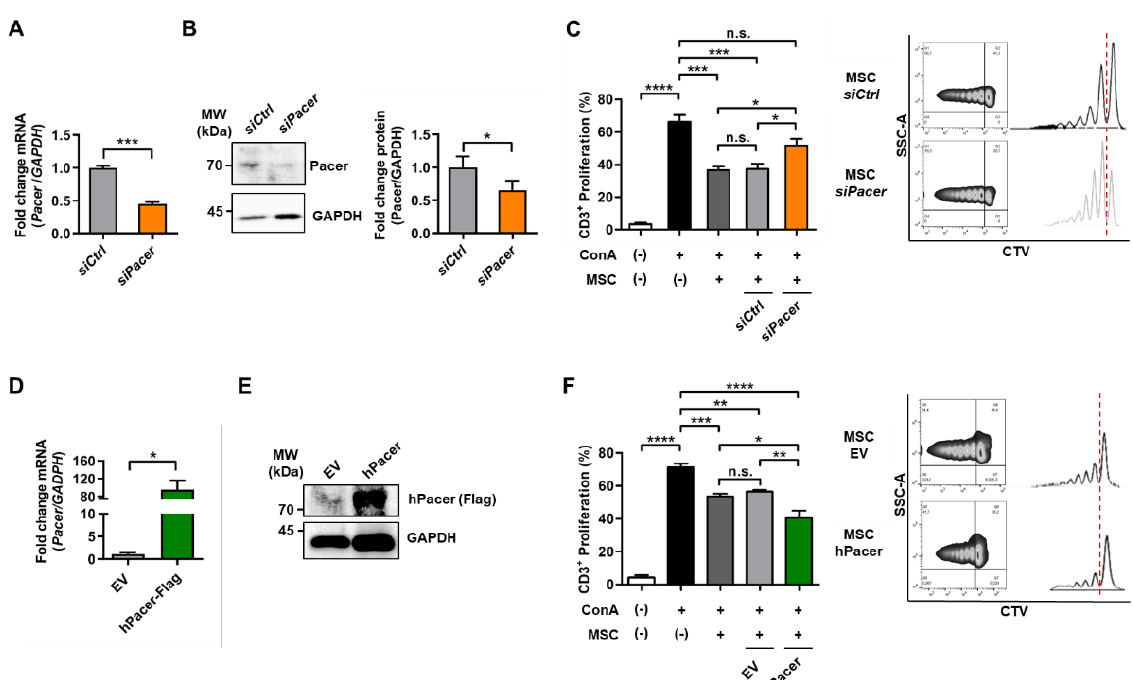
Figure 3. Increased levels of Pacer in MSC enhance their immunosuppressive capabilities upon T cells. ( A – C ) Depletion of endogenous Pacer levels in MSC using siRNA oligos. ( A ) mRNA levels of Pacer in MSC treated with si Pacer or si Ctrl oligos analyzed by quantitative PCR ( n = 4). GAPDH mRNA levels are used as a reference. ( B ) Western blot and quantitative analysis of Pacer levels in MSC transiently transfected with si Pacer or si Ctrl oligos ( n = 4). GADPH protein levels are used as a loading control. ( C ) Co-culture assay of CD3-positive (CD3+) splenocytes with MSC transiently transfected with si Pacer or si Ctrl oligos ( n = 7). Splenocyte proliferation was induced with 1 µ g/mL Concanavalin A (ConA). T-cell proliferation was evaluated using flow cytometry, gating SytoxGreen-negative staining (live CD3+ cells) and assessing cell trace violet (CTV) staining. ( D – F ) Augmented expression of Pacer in MSC transduced with lentiviral particles carrying human Flag-tagged Pacer (hPacer) or an empty control vector (EV). ( D ) mRNA levels of total Pacer in hPacer and EV MSC was determined by qPCR using primers recognizing mouse and human Pacer mRNA with comparable efficiency ( n = 4). GAPDH mRNA levels are used as a reference. ( E ) Western blot analysis of Flag-tagged human Pacer expression in MSC. GAPDH protein levels were used as a loading control. ( F ) Co-culture assay of CD3-positive (CD3+) splenocytes with hPacer or EV MSC ( n = 4). Splenocyte proliferation was induced with 1 µ g/mL Concanavalin A (ConA). T-cell proliferation was evaluated using flow cytometry, gating SytoxGreen-negative staining (live CD3+ cells) and assessing cell trace violet (CTV) staining. In ( A – D , F ), Mean ± SEM are shown. In ( A , B , D ), Student’s t -test was performed ( n = 4) and in ( C , F ), one-way ANOVA with Tukey post hoc test was performed for statistical analysis ( n = 7). Only significant p values are shown. p values: *, p ≤ 0.05; **, p ≤ 0.01; ***, p ≤ 0.001; ****, p ≤ 0.0001. 3.3. Increasing Pacer Levels in MSC Improves Their Therapeutic Effect in a Mouse Model of DSS-Induced Colitis Since increased Pacer levels enhanced the immunosuppressive capacity of MSC in vitro, we tested whether hPacer-MSC have a comparable effect in vivo. To explore this potential effect, we used the DSS-induced acute inflammatory colitis mouse model. Feed- ing mice for several days with DSS polymers in the drinking water induces an acute colitis characterized by weight loss, bloody diarrhea, rectal bleeding, ulcerations and infiltra- tions with granulocytes. In our protocol, we used DSS at a concentration of 2.5% ( w / v ) in the drinking water for 7 days, which induces strong colitis with very low mortality rates [12]. EV-MSC or hPacer-MSC were intraperitoneally injected into the mice on day 3 of the DSS treatment (Figure S2A). The overexpression of hPacer significantly improved the therapeutic effects of MSC toward intestinal injury, which was assessed by determining the disease activity index (Figure 4A), which included weight recovery (Figure S2B). At day 14, the large intestine and cecum were extracted from the peritoneal cavity. The colon